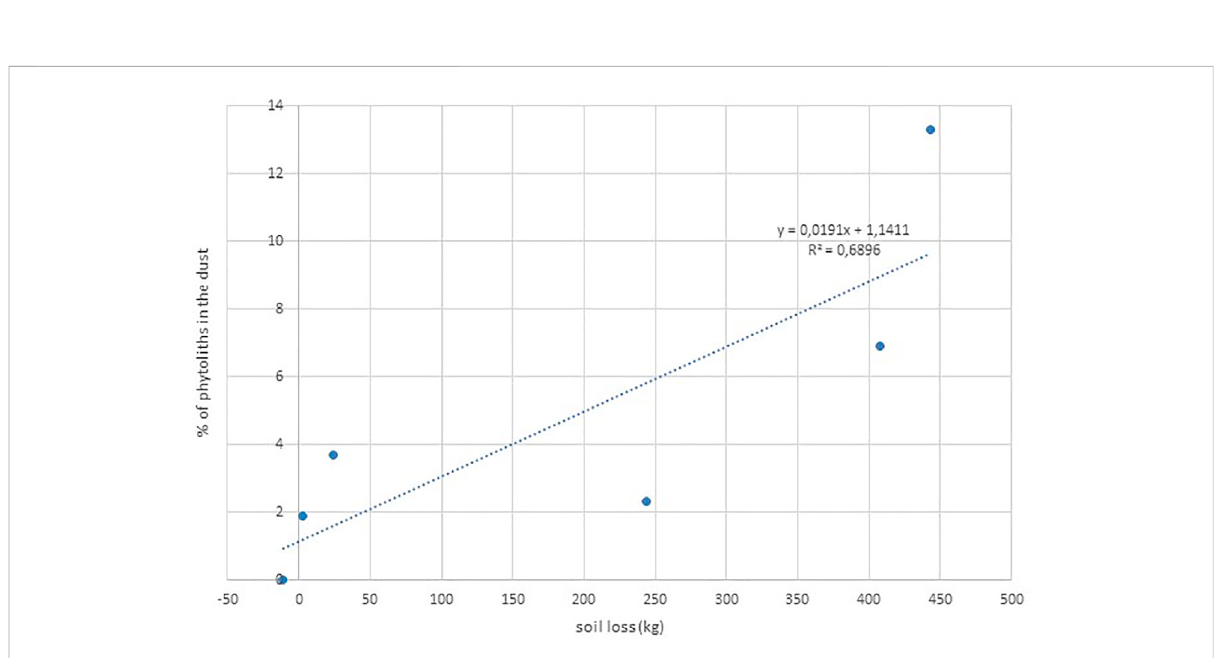
FIGURE 5 Percentage of phytoliths in the dust in dependence on wind erosion